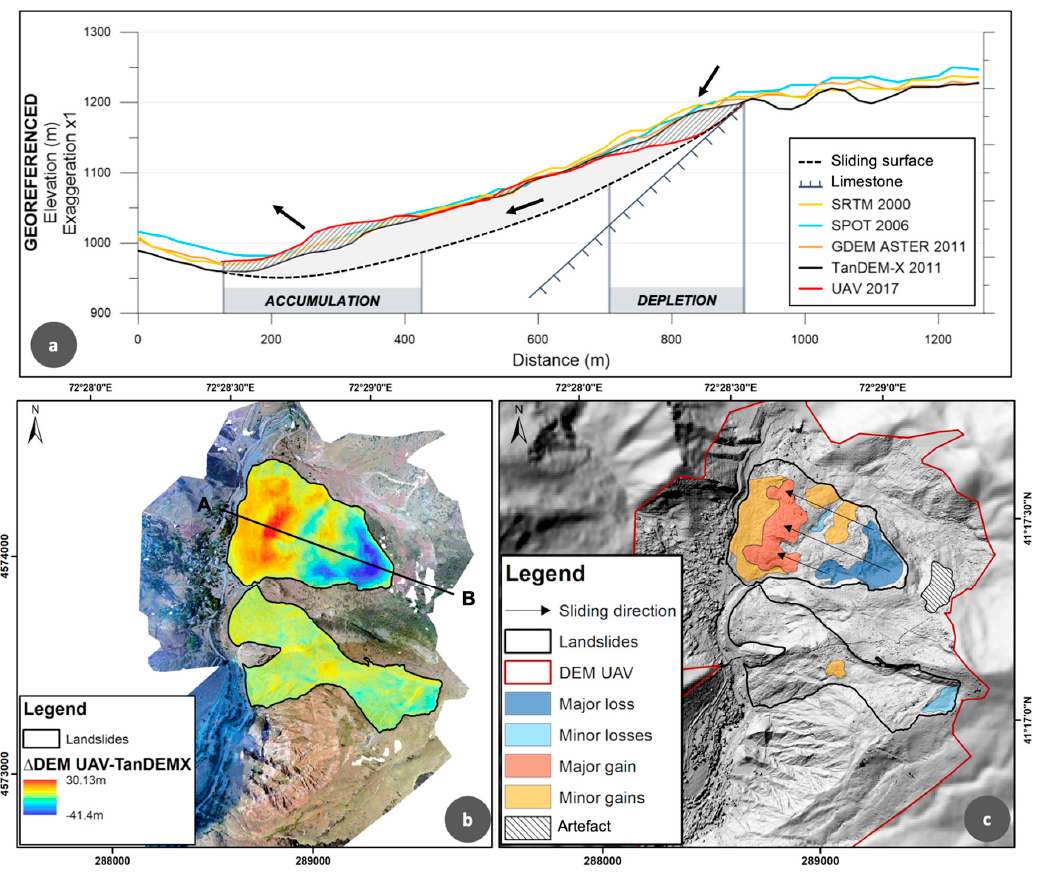
Figure 7. ( a ) A-B profiles of the DEMs, along the main axis of Koytash landslide, georeferenced according to the DGPS stable points and acquired for the Mailuu-Suu area (N41E072) since 2000. The black arrows indicate the roto-translational movement of the landslide. ( b ) Difference in topography for the Koytash and Tektonik landslides resulting of the operation [ ∆ DEM = DEM UAV —DEM TanDEM-X ]. The contours of the landslides are underlined in black. ( c ) Delimitation of the loss and gain zones (major and minor) as well as the spatial extension of the UAV DEM (red line). The black arrows display the projected sliding direction. The delimited artifact refers to a zone with missing data probably due to an excess of